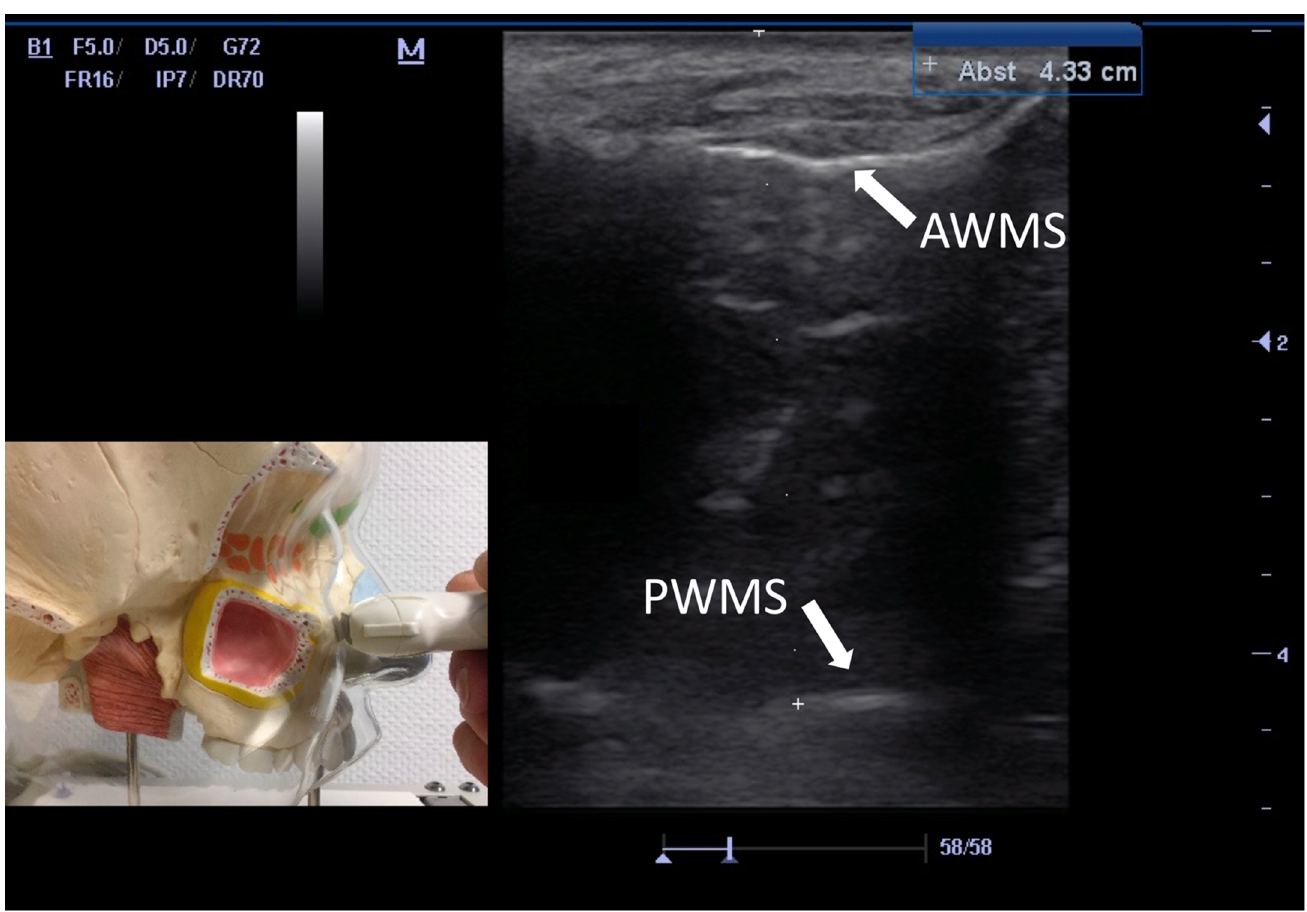
Figure 3. B-scan US of corresponding maxillary sinus from Figure 2. The osseus anterior wall of the maxillary sinus (AWMS) is identified at 1 cm depth. At a depth of 4.33 cm, the backscatter echo is depicted as hyperechoic back wall reflex (PWMS = posterior wall of the maxillary sinus).